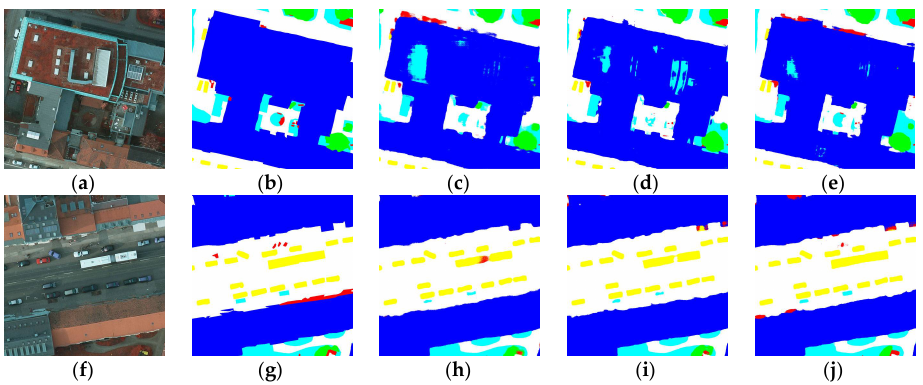
Figure 8. Semantic Labeling results for two patches of Potsdam validation set. Classes: impervious surface (white); buildings (blue); low vegetation (cyan); tree (green); car (yellow); clutter (red). In the first row, ( a ) is true orthophoto, ( b ) is ground truth, ( c – e ) are inference results of FSN-noMLP, FSN-noSC and the proposed FSN for image patch with building with roof lawn; in the second row, ( f ) is true orthophoto, ( g ) is ground truth, ( h – j ) are inference results of FSN-noMLP, FSN-noSC and the proposed FSN for image patch with a street between buildings.